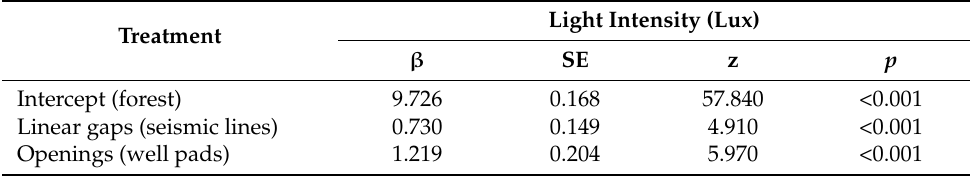
Table 1. Mixed effect regression predicting average light intensity (lux) as a function of treatment type using a Gamma model transformation across 46 sites in northeast Alberta, Canada, with model coefficients ( β ), Standard Error of the coefficients (SE), z-score (z), and significance ( p ) reported. Light Intensity (Lux) Treatment β SE